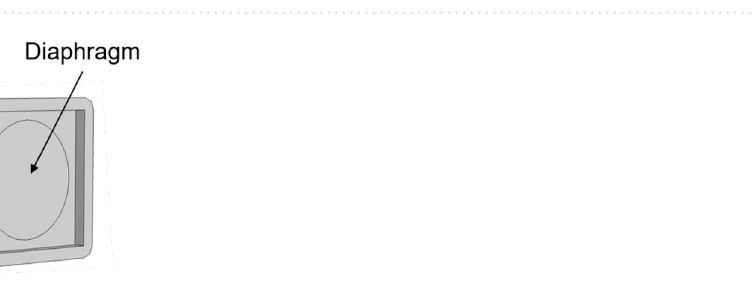
Figure 3. Configuration of an oscillating ring in a finite closed back baffle to consider the interaction between the speaker and the barrier.